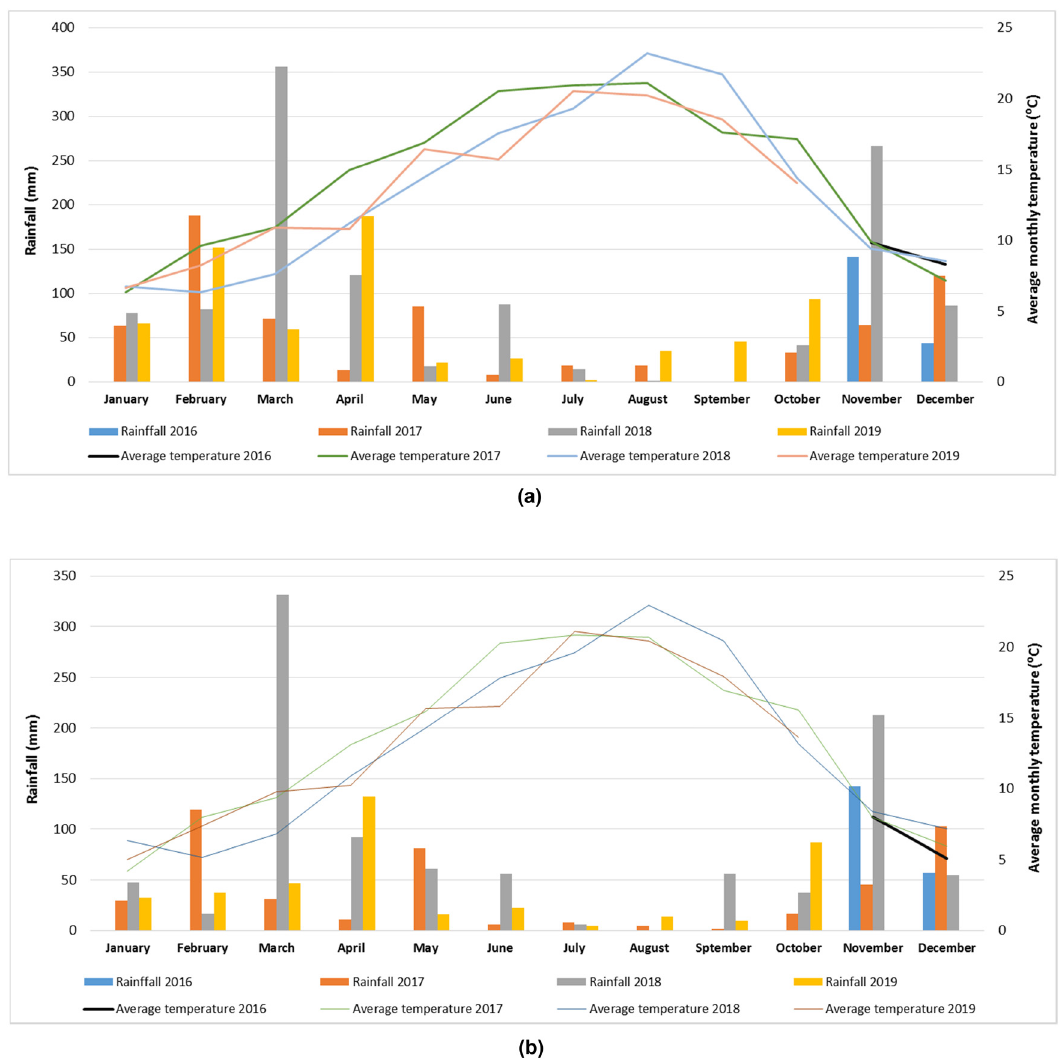
Figure 2: Average monthly temperature ( °C ) and rainfall ( mm ) in the three agricultural years for ( a ) Viseu, Centre of Portugal and ( b ) Sernancelhe, North of